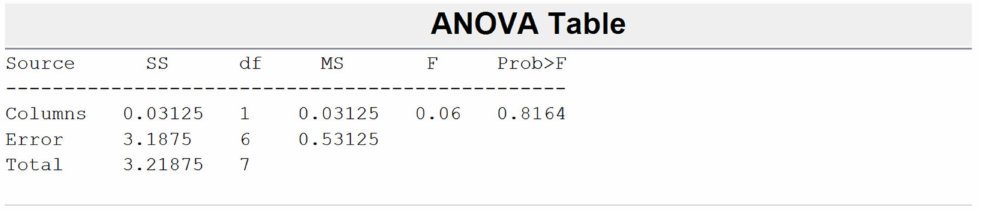
Figure 5. ANOVA results of singed